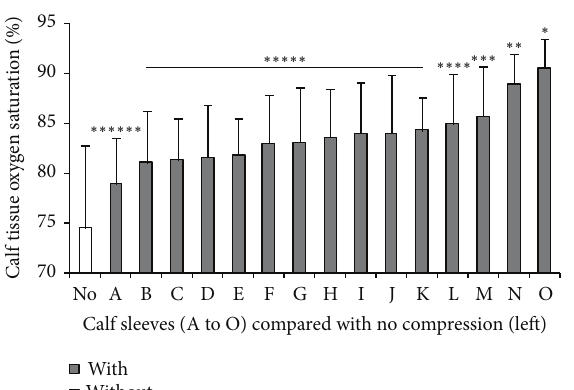
Figure 2: Calf StO 2 recorded with or without calf compression sleeves. ∗ Significantly different from all other calf sleeves includ- ing no compression. ∗∗ Significantly different from A to M and no compression. ∗∗∗ Significantly different from A to F and no compression. ∗∗∗∗ Significantly different from A to E and no com- pression. ∗∗∗∗∗ Significantly different from A and no compression. ∗∗∗∗∗∗ Significantly different from no compression.